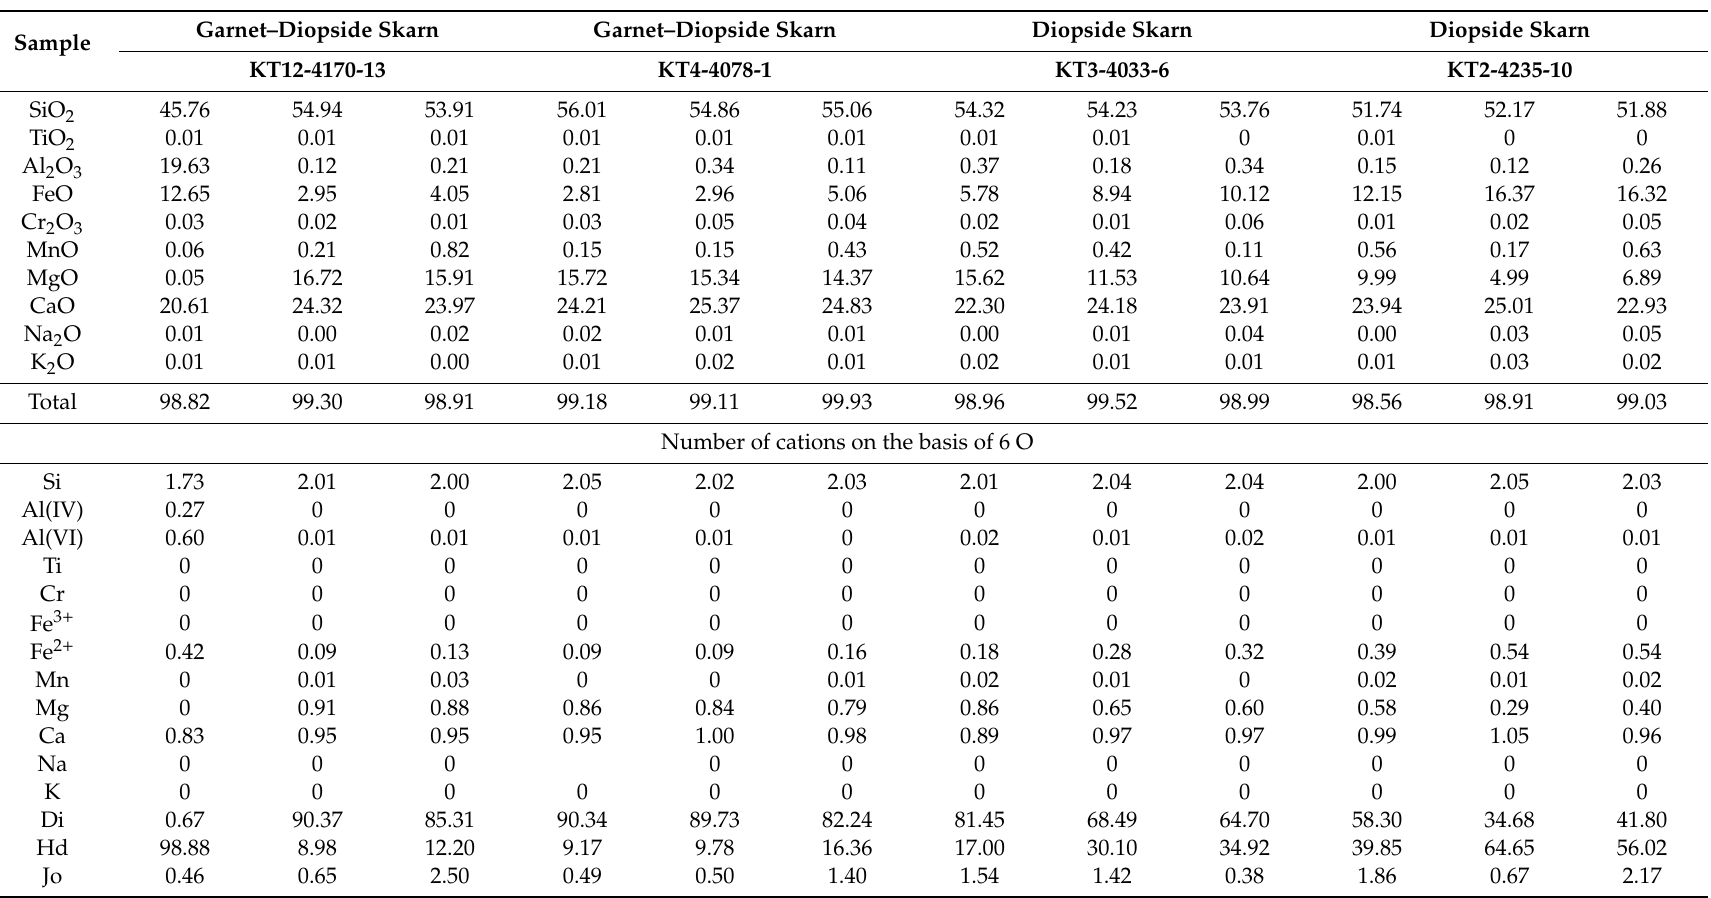
Table 4. Electron microprobe analyses of diopside from the Hongshan deposit (wt